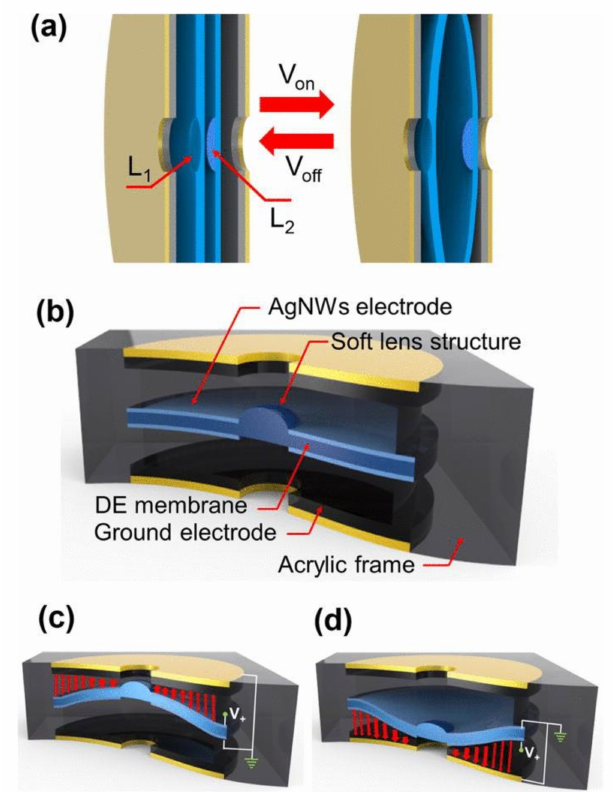
Figure 10. Structural configurations of ( a ) an active-lens module electrically controlling a gap- distance between the lens structures and ( b ) an active lens. ( c , d ) Illustrated operating principle of the active-lens producing bi-directionally controllable movement of the lens-structure responding to a compositive driving force (Reproduced with permission from [139]. Copyright AIP,